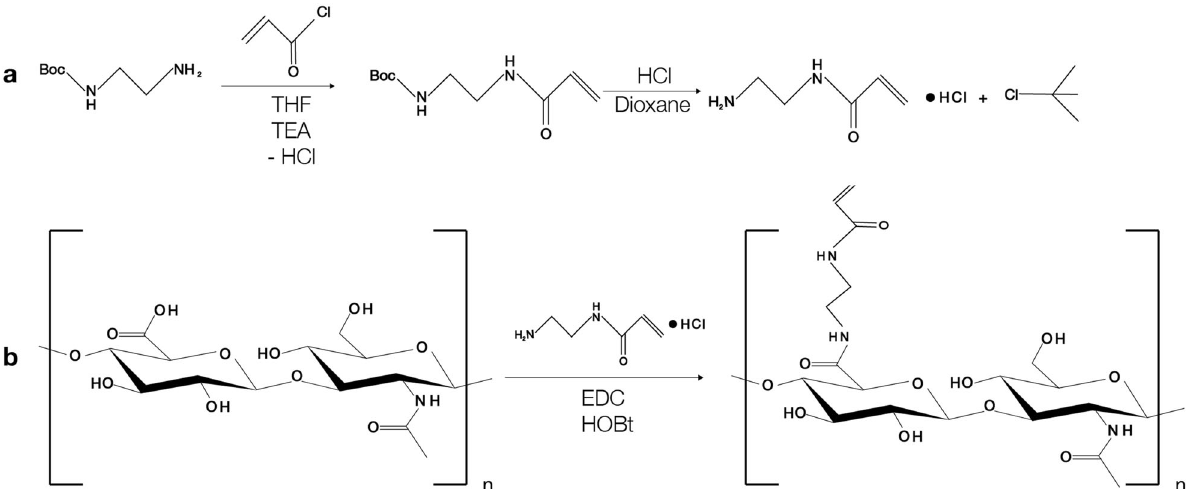
Fig. 1 A Synthesis of N -(2-aminoethyl) acrylamide linker and B subsequent preparation of HA-am derivative by amidation of native HA with the